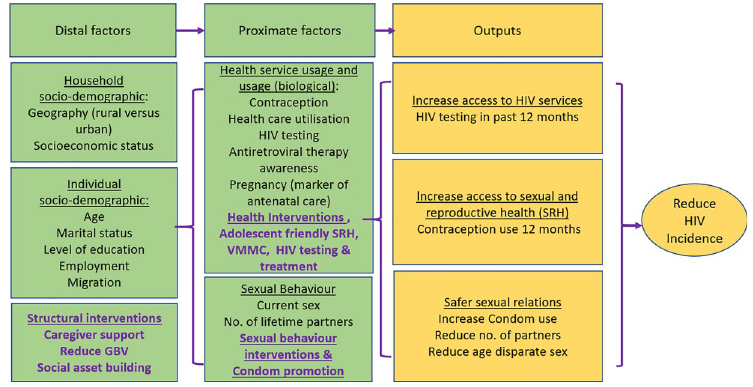
Fig 1. Conceptual framework for effect of combination prevention on HIV incidence in adolescent girls and young women.